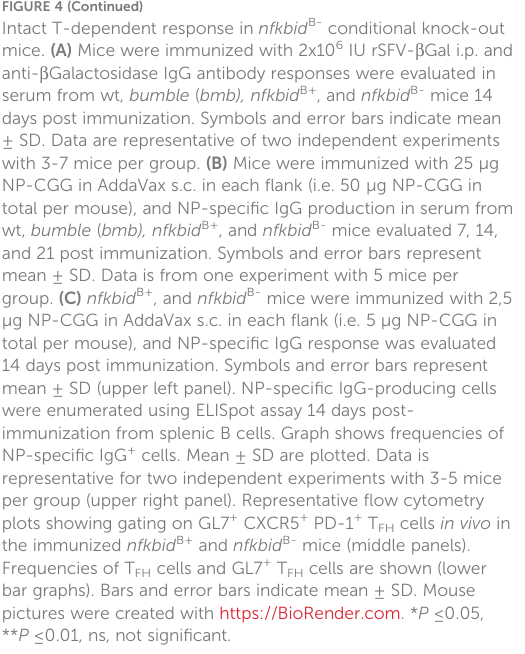
NP-speci fi c IgG + cells. Mean ± SD are plotted. Data is representative for two independent experiments with 3-5 mice per group (upper right panel). Representative fl ow cytometry plots showing gating on GL7 + CXCR5 + PD-1 + T FH cells in vivo in the immunized nfkbid B+ and nfkbid B- mice (middle panels). Frequencies of T FH cells and GL7 + T FH cells are shown (lower bar graphs). Bars and error bars indicate mean ± SD. Mouse pictures were created with https://BioRender.com. * P ≤ 0.05, ** P ≤ 0.01, ns, not signi fi